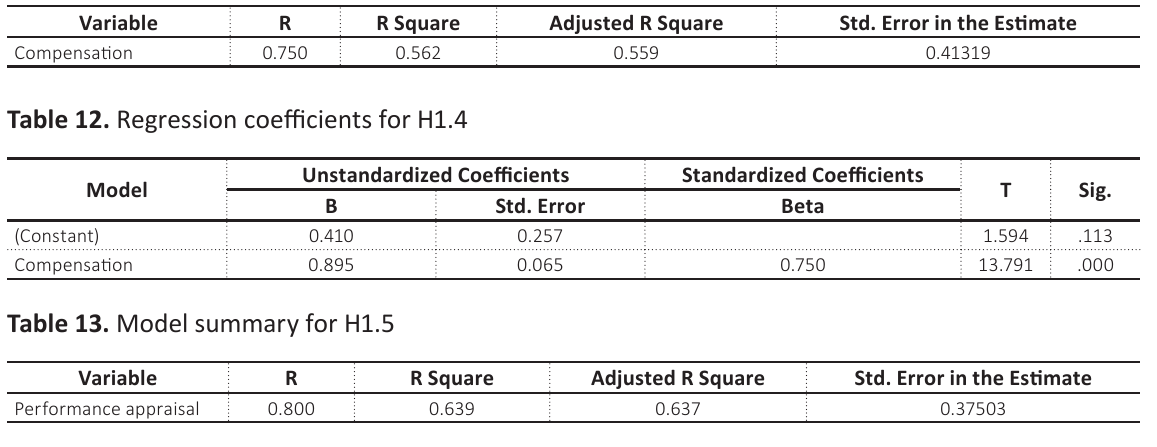
Table 11. Model summary for H1.4